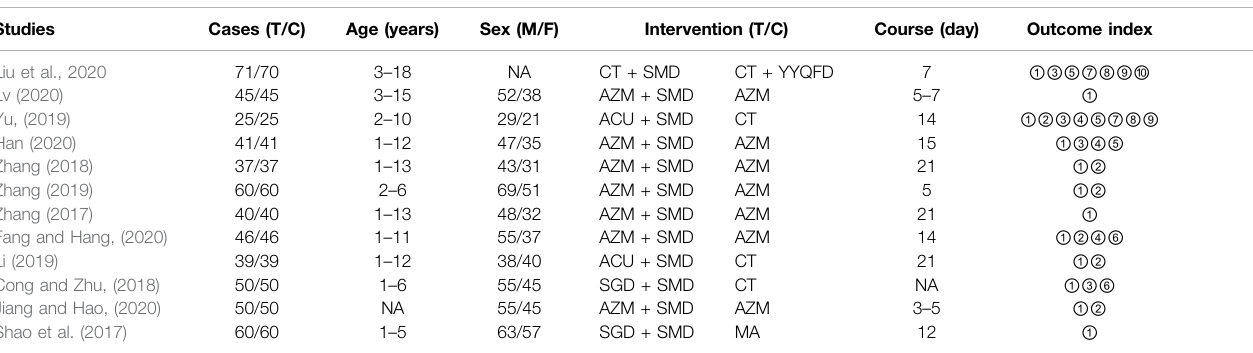
TABLE 2 | Basic characteristics of the included